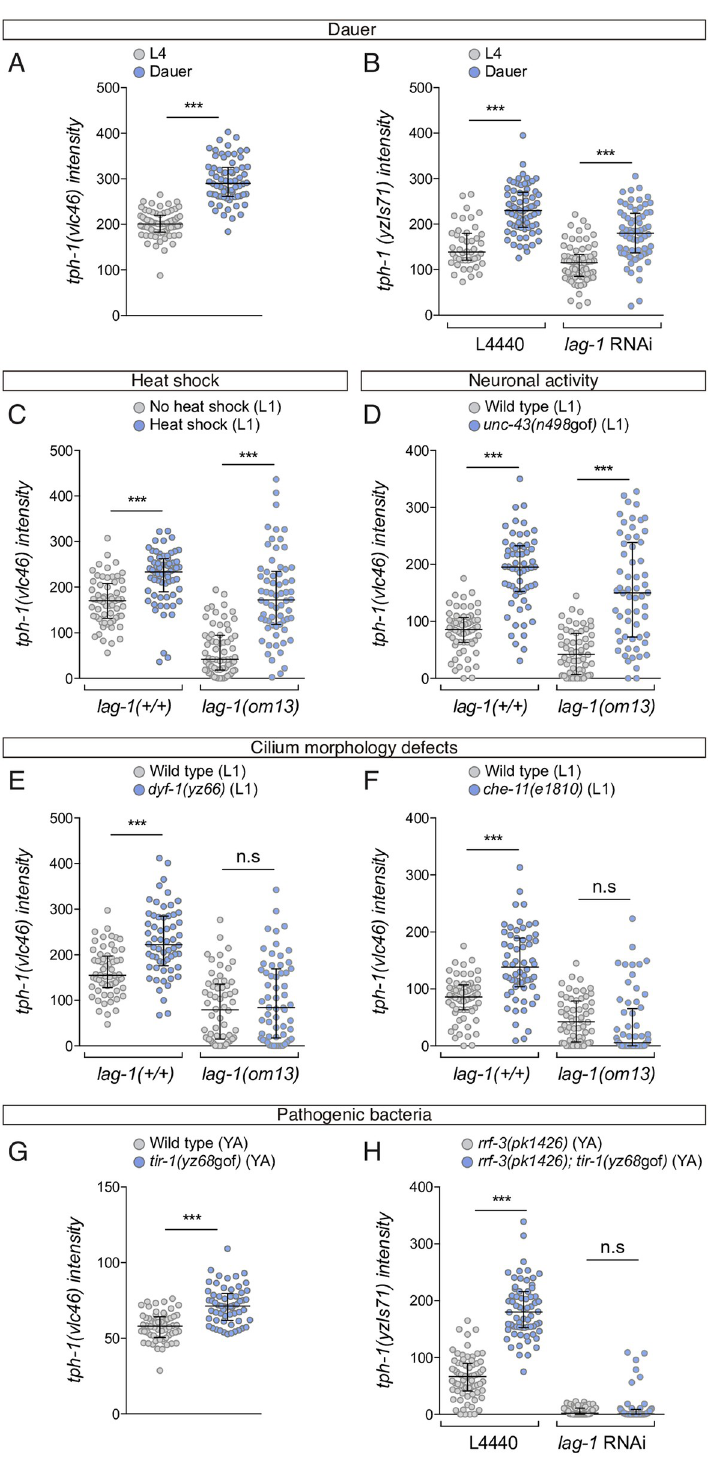
Fig 7. LAG-1 mediates tph-1 expression induction by specific stimuli. (A) ADF mNeonGreen intensity quantification of tph-1(vlc46) endogenous reporter in dauer stage shows a significant increase compared to L4. n > 60 neurons. Median and IQR are represented. See S1 Data for numerical values. (B) Dauer animals show increased ADF yzIs71(tph-1 :: gfp) reporter expression both in lag-1 RNAi and control animals, suggesting that LAG-1 does not mediate tph-1 induction in dauer. Median and IQR are represented. See S1 Data for numerical values. (C) L1